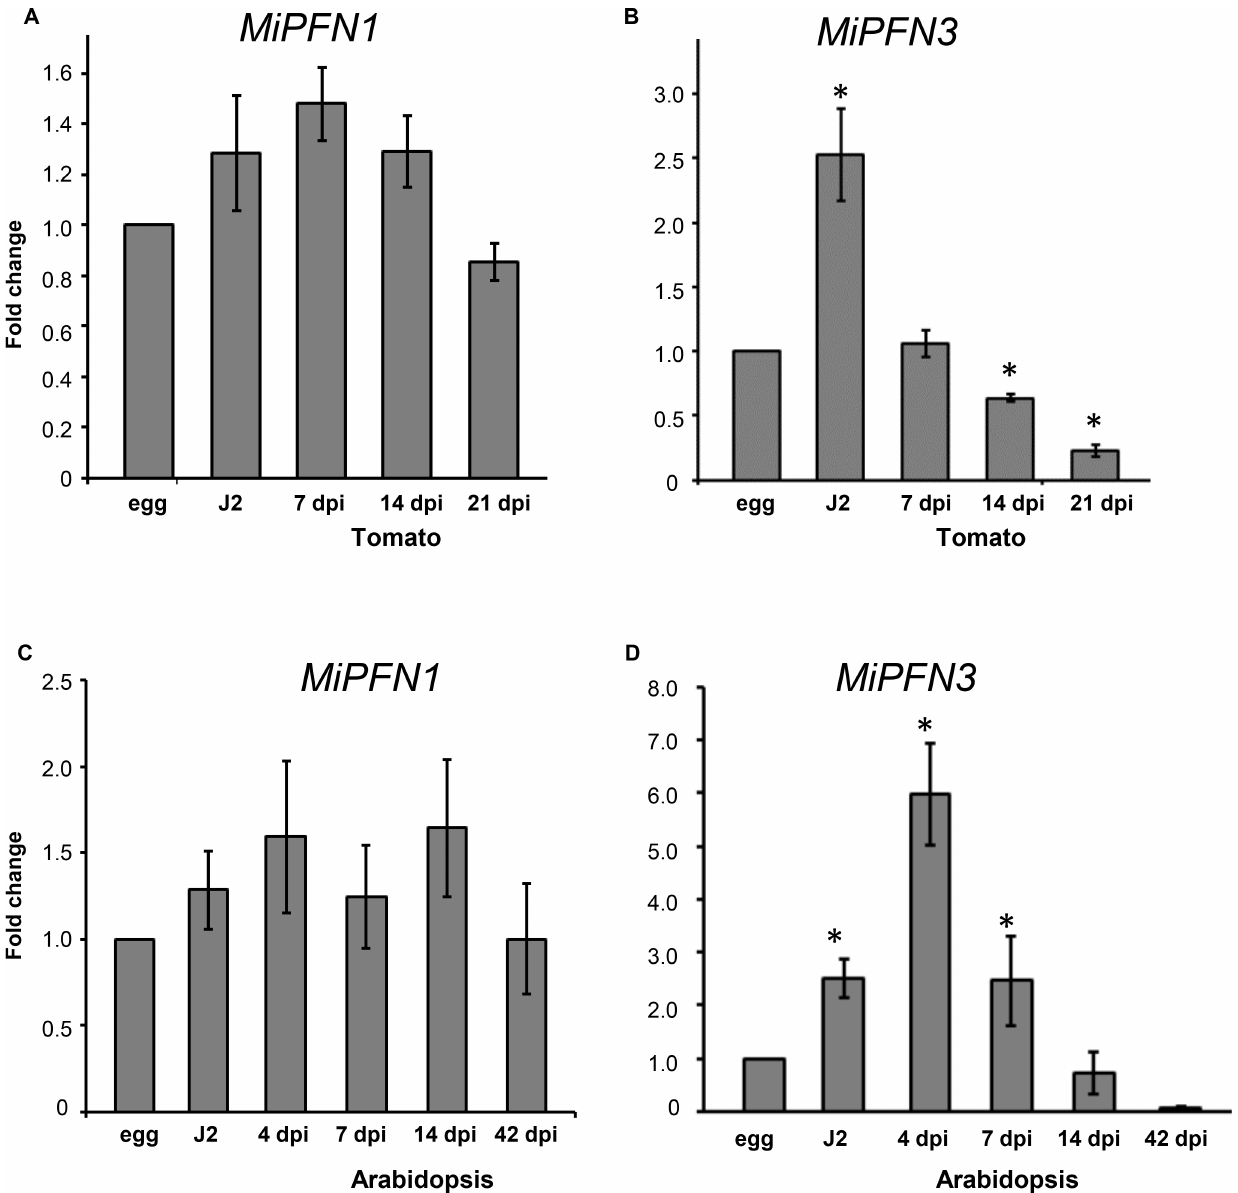
Fig 2. Expression of M . incognita profilin genes MiPFN1 and MiPFN3 in M . incognita at different life stages. The relative expression of (A) MiPFN1 and (B) MiPFN3 in eggs, J2, and nematodes inside tomato tissues at 7, 14, and 21 days post-inoculation was determined by Real-Time qRT-PCR. The relative expression of (C) MiPFN1 and (D) MiPFN3 in eggs, J2, and infective Arabidopsis roots at 4, 7, 14, and 42 dpi was also determined by Real-Time qRT-PCR. The fold change values were calculated using the 2- ΔΔ Ctmethod using reference gene MiGAPDH . Data presented as the change in expression relative to that of egg. The mean values (± SD) of the fold change for three biological replicates. (cid:3) , P < 0.05, One sample t-test.